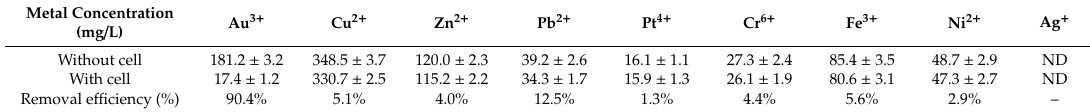
Table 1. Recovery of Au (III) from aqua regia-based metal wastewater in the first cycle. Metal Concentration (mg / L)